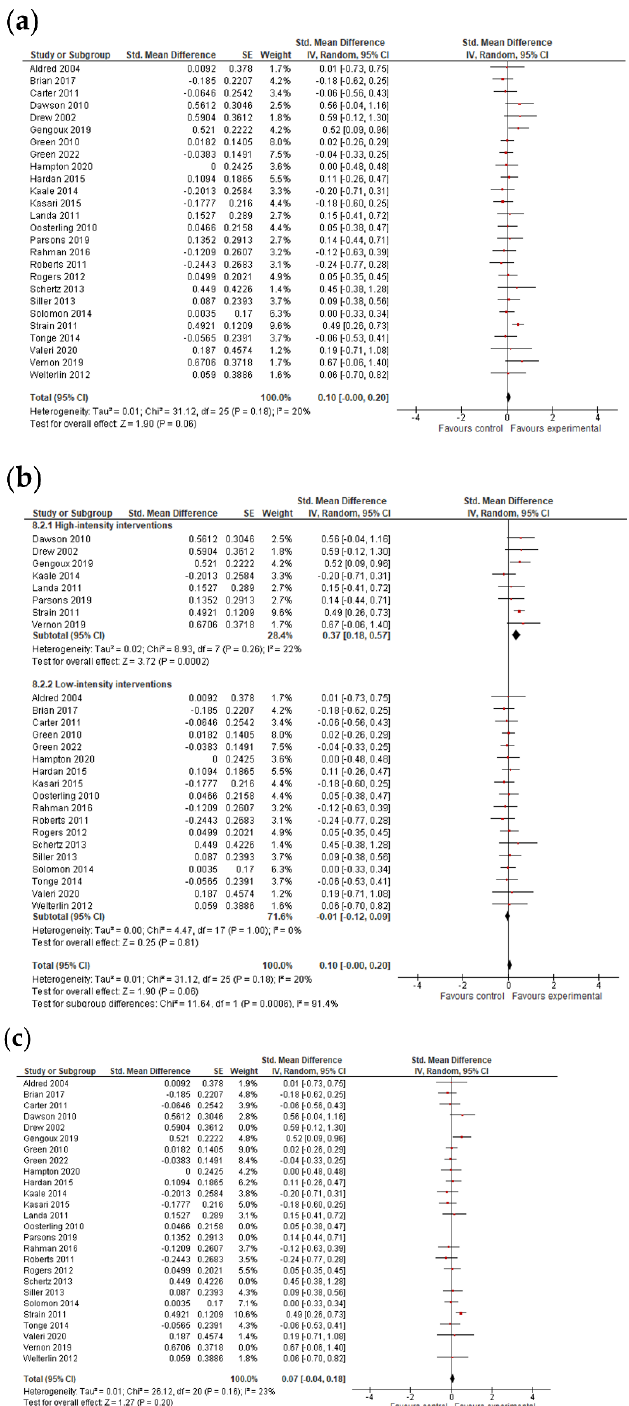
Figure 4. Forest plots for expressive language results. ( a ) Overall effect [27–30,32,34–44,47,48,51–55,57–59]. ( b ) Subgroup analysis: intensity of intervention. ( c ) Results after exclusion of studies with no blinding of outcome assessment [27–30,34–41,44,47,48,52–55,57,59]. The test for subgroup differences indicated that there was no statistically significant subgroup effect ( p = 0.16 for expressive language and p = 0.09 for receptive language; anal- ysis not presented), suggesting that intervention duration does not modify the effect of